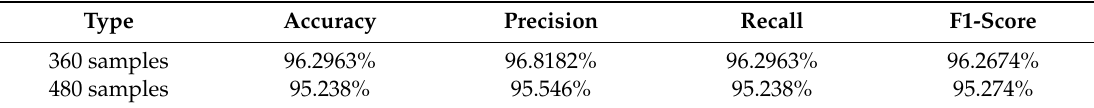
Table 1. The performance of the proposed approach on the ASL dataset.